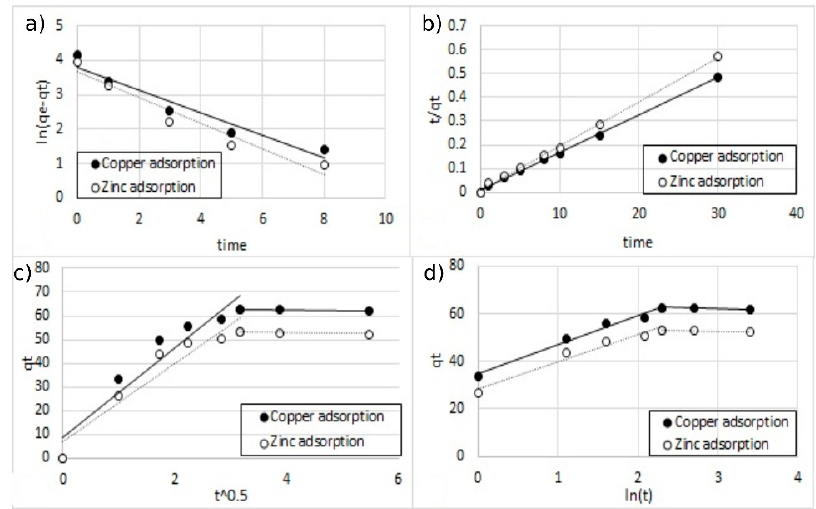
Figure 16. The fitting of different kinetic models for double-ion adsorption (Cu 2+ and Zn 2+ ) onto MA functionalized with 5% of coating, ( a ) pseudo-first-order, ( b ) pseudo-second-order, ( c ) Elovich model, and ( d ) intra-particle diffusion model.